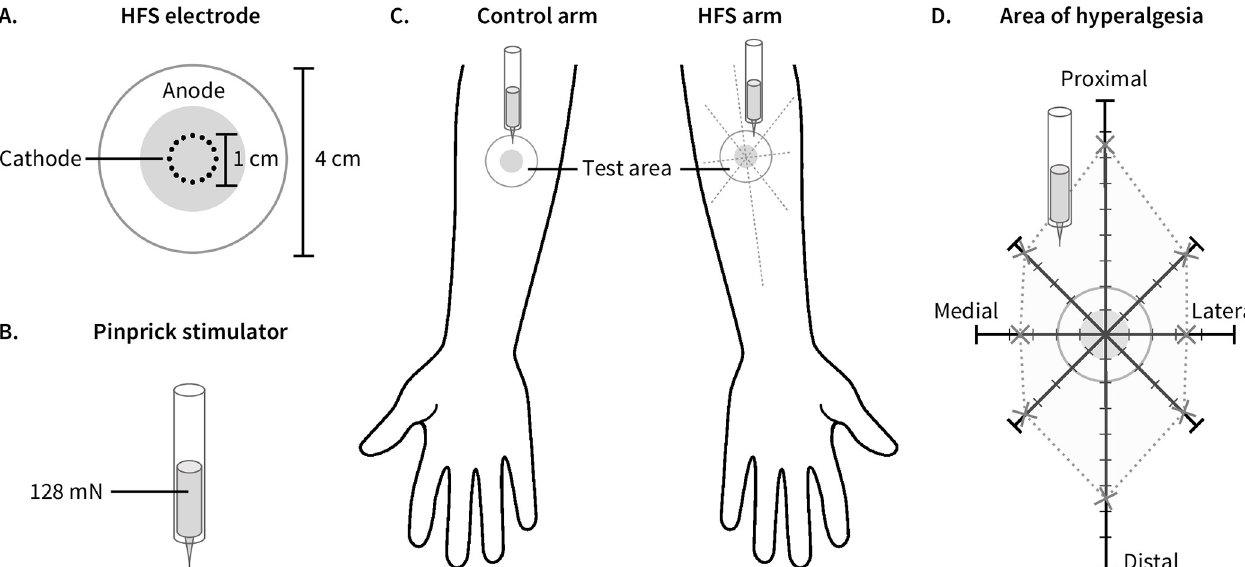
Fig 3. Experimental setup. (A) Electrode used to deliver HFS with its 16 blunt stainless-steel pins placed in a 10-mm diameter circle (cathode), surrounded by the concentrically located stainless steel anode. (B) We used a 128 mN mechanical pinprick stimulator for all measures of intensity of perception to mechanical stimuli. (C) We applied high frequency electrical stimulation of the skin (HFS) to the dominant volar forearm. We assessed the intensity of perception to mechanical stimuli in the area surrounding the area where HFS was applied, as well as in the same skin area on the contralateral (control) arm. (D) We mapped the size of the area of increased pinprick sensitivity by applying mechanical pinprick stimuli every centimetre along eight different radial axes, from the periphery towards the centre of the